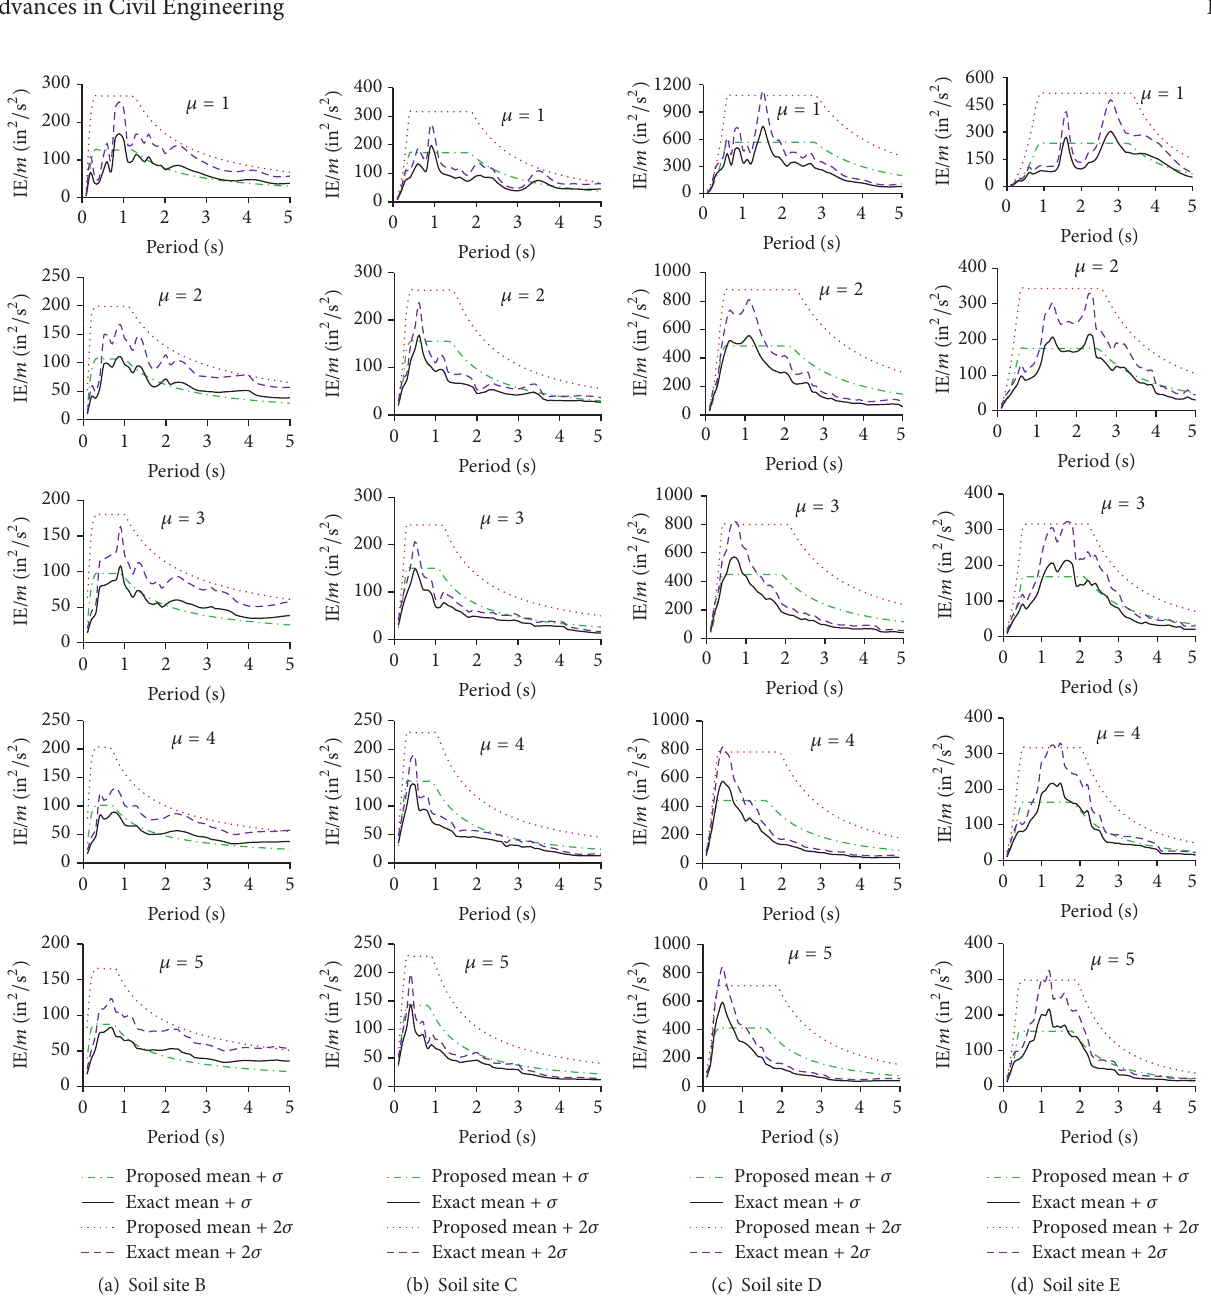
Figure 9: Comparative study of proposed input energy spectra: hysteretic model BS ( 𝜁 = 5 %, 𝛼 = 0.05